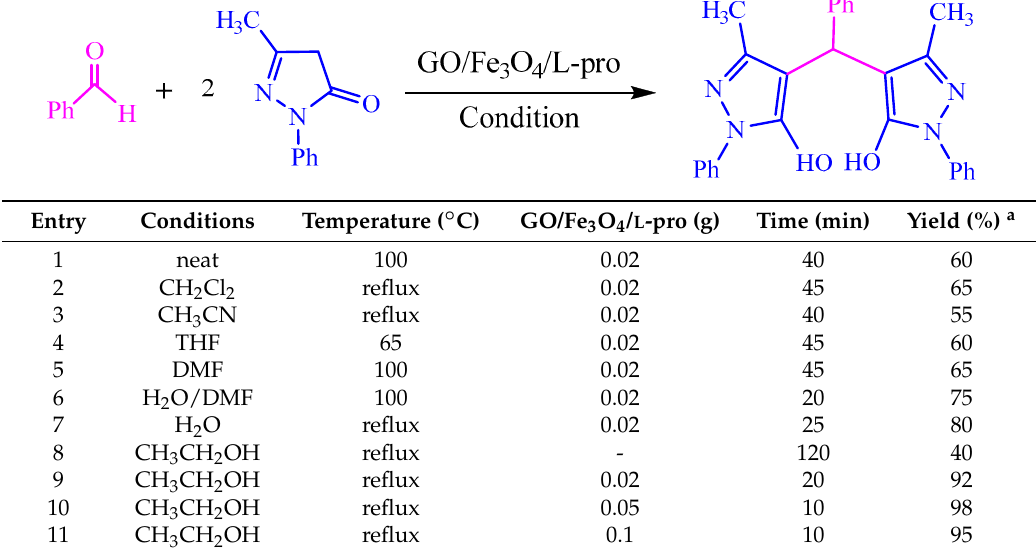
Table 1. Investigation of catalytic activity of GO/Fe 3 O 4 / L -pro for the synthesis of -bis-pyrazole ( 3a ) under various Conditions.